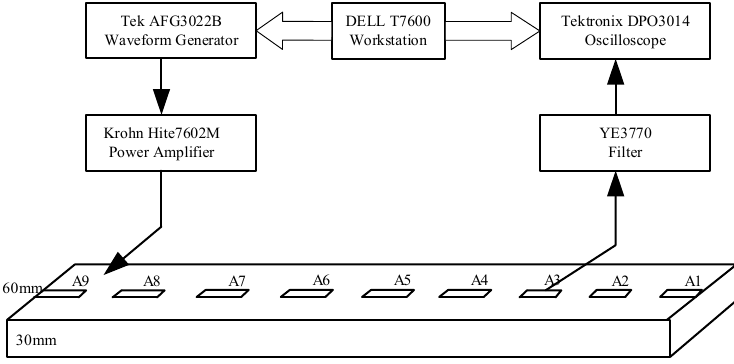
Figure 8. Experiment system of stator insulation damage detection.